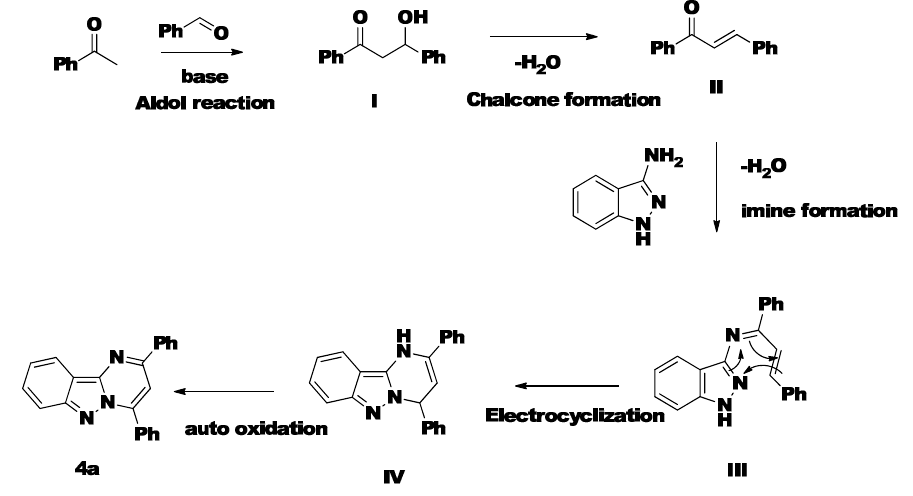
Scheme 1. Plausible mechanism of the synthesis of compound 4a .